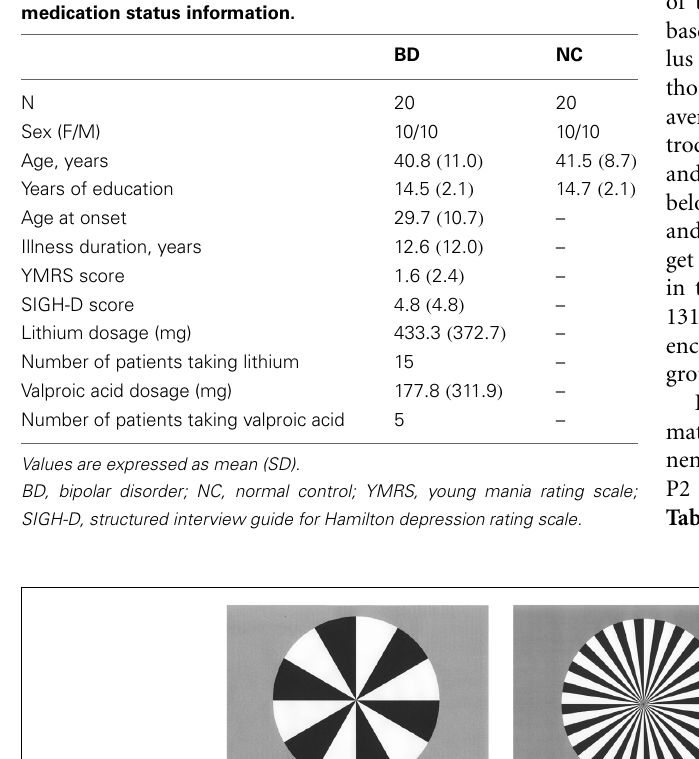
adopted as standard or deviant stimuli (counterbalanced across sessions) and the white circle was always used as the target stimulus. Probabilities of standard, deviant, and target stimuli were 8:1:1,